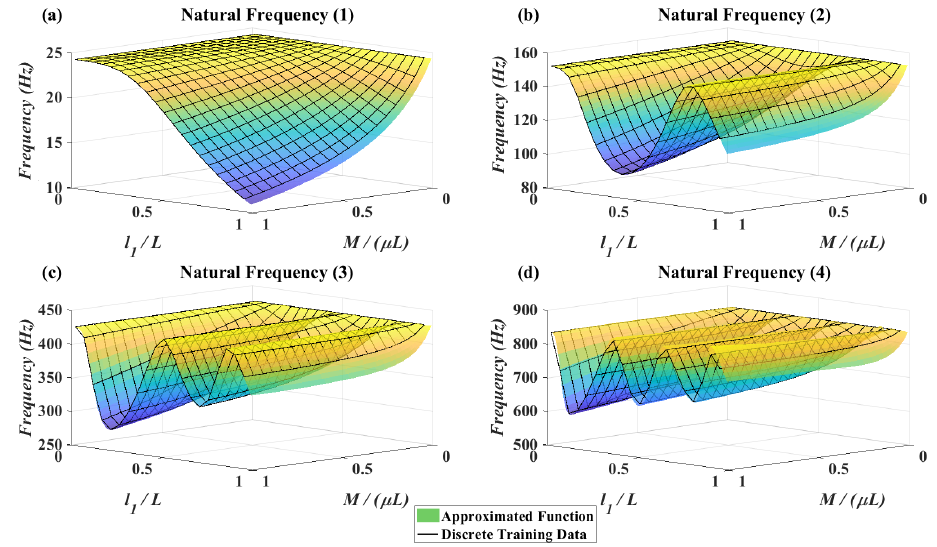
Figure 9. MLP neural network approximated function and discrete training data— J = 0.